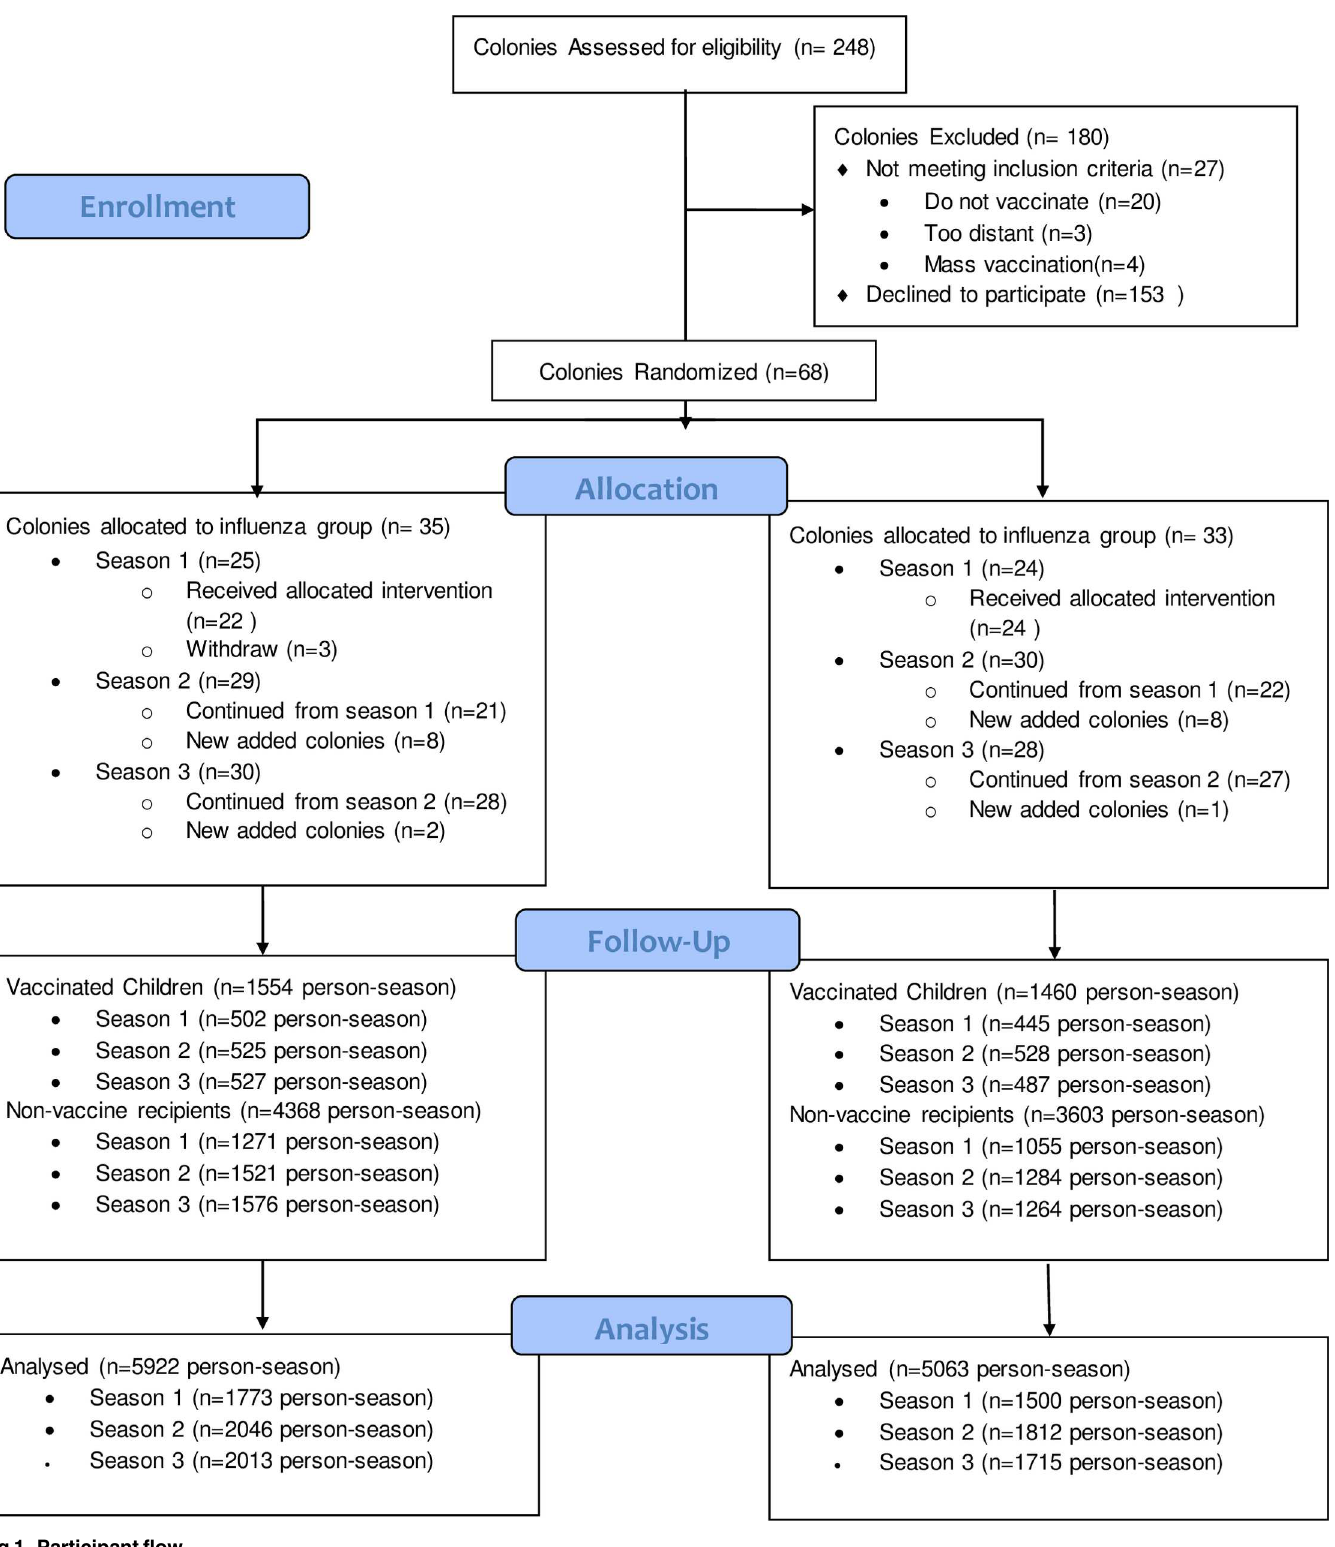
PLOS ONE | DOI:10.1371/journal.pone.0167281 December15,